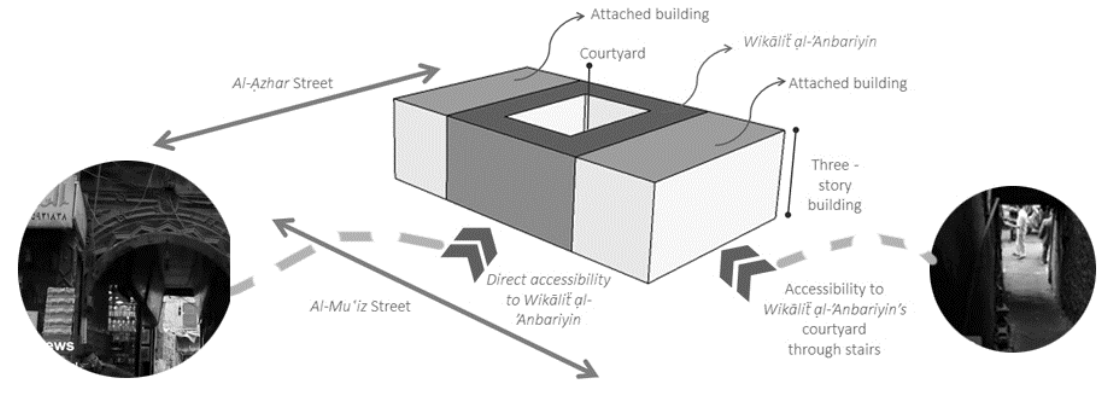
Figure 12. A sketch that shows the attached buildings to Wikāliẗ ạl - ’Anbariyin and its courtyard